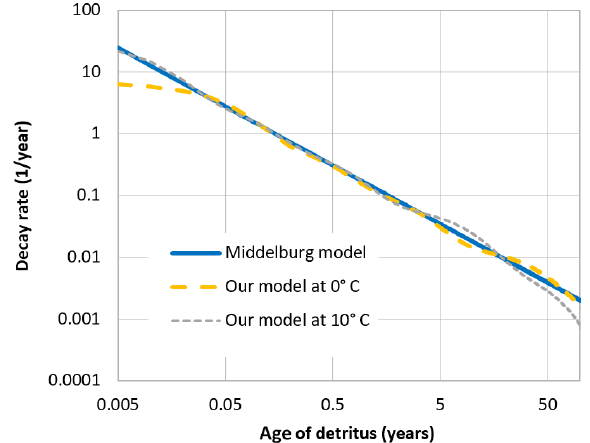
Figure B1. Decay rates of organic carbon in detritus depending on its time of creation. Comparison of the reactivity predicted by our model at different temperatures to the Middelburg decay rate pre- diction; see